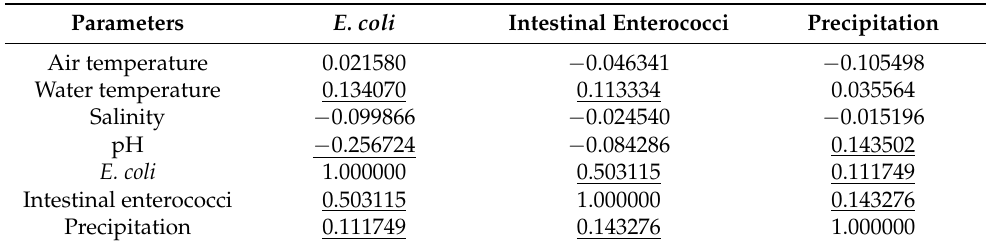
Table 3. Spearman correlation coefficients between the examined variables for both bathing seasons for Split area. Statistically significant correlations ( p < 0.05) are